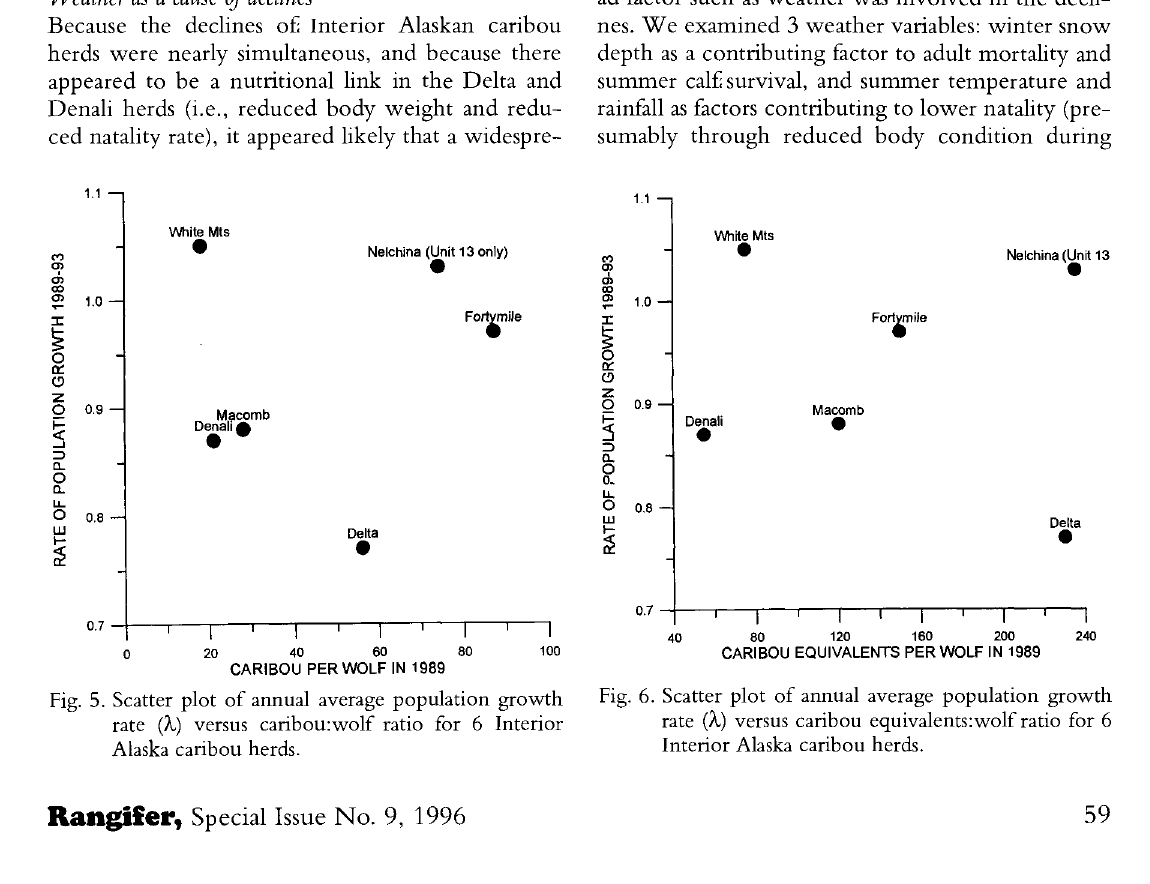
Fig. 5. Scatter plot of annual average population growth rate (A.) versus caribou:wolf ratio for 6 Interior Alaska caribou herds.